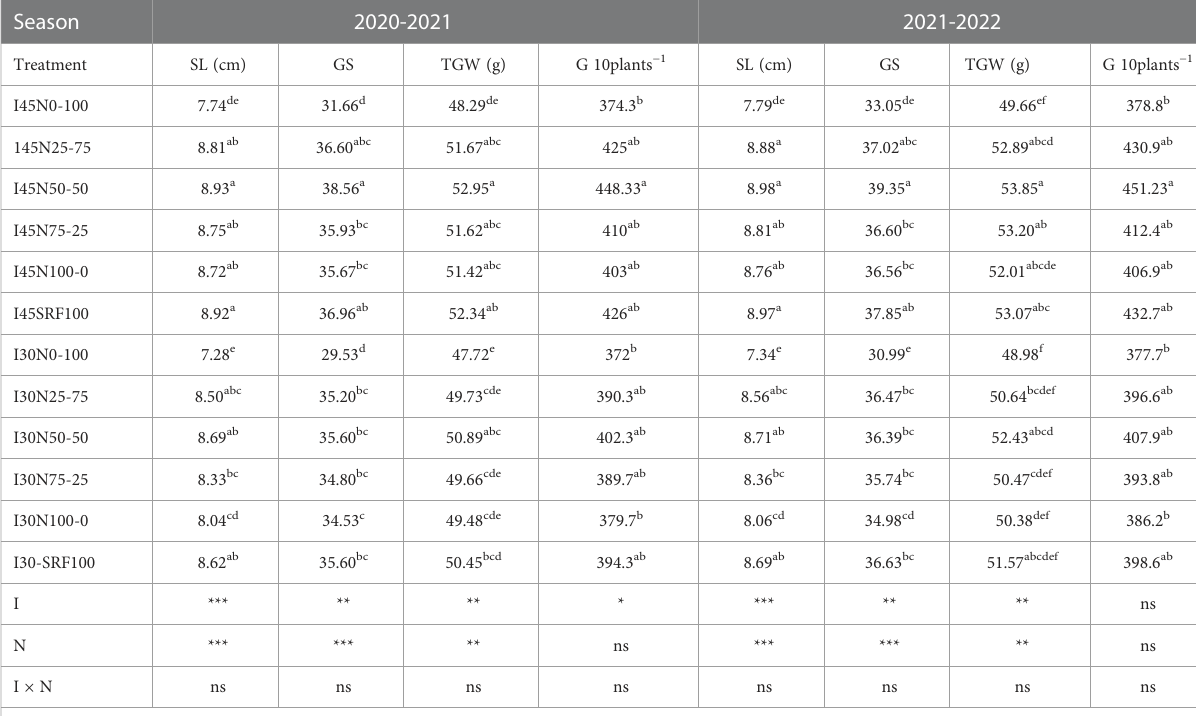
TABLE 4 Interactive effect of different irrigation scheduling and nitrogen application modes on winter wheat yield components during 2020- 2021 and 2021-2022 growing seasons.